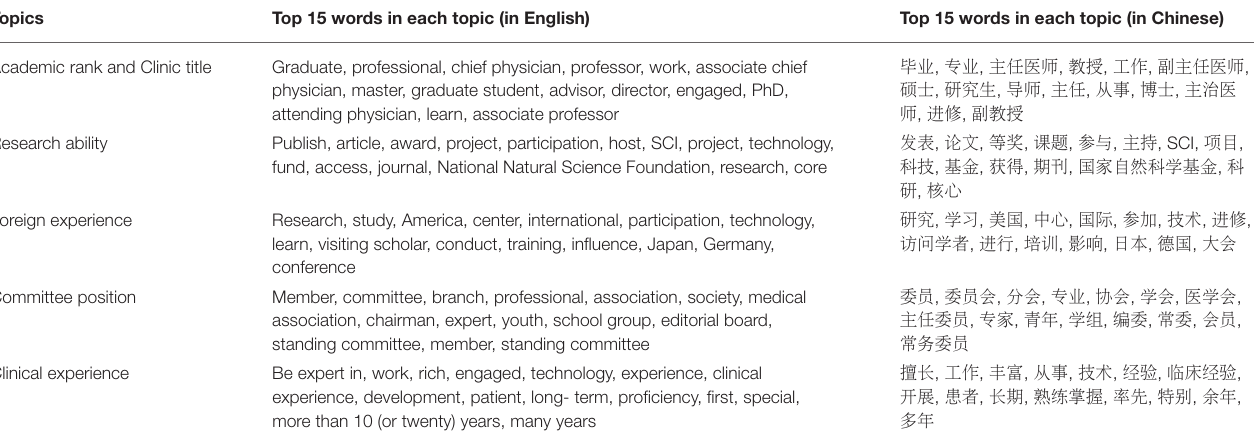
TABLE 2 | Most relevant words related to topics in the physicians’ personal profiles. Topics Top 15 words in each topic (in